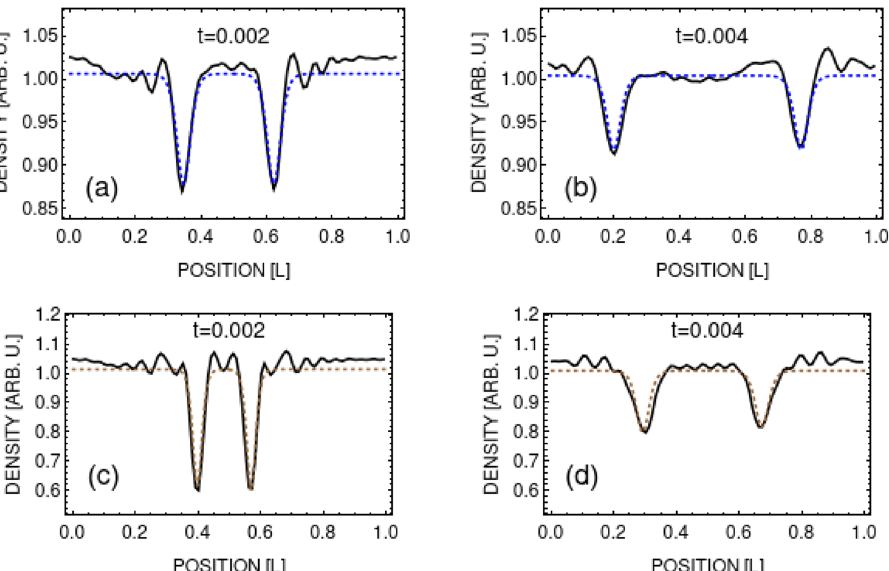
2 / 50, d 5 / 16 , which corresponds = = 0.90 c q B ). For frames ( a , b ), i.e. before the ˙ = 0.77 c q B for ( c ) and ˙ =